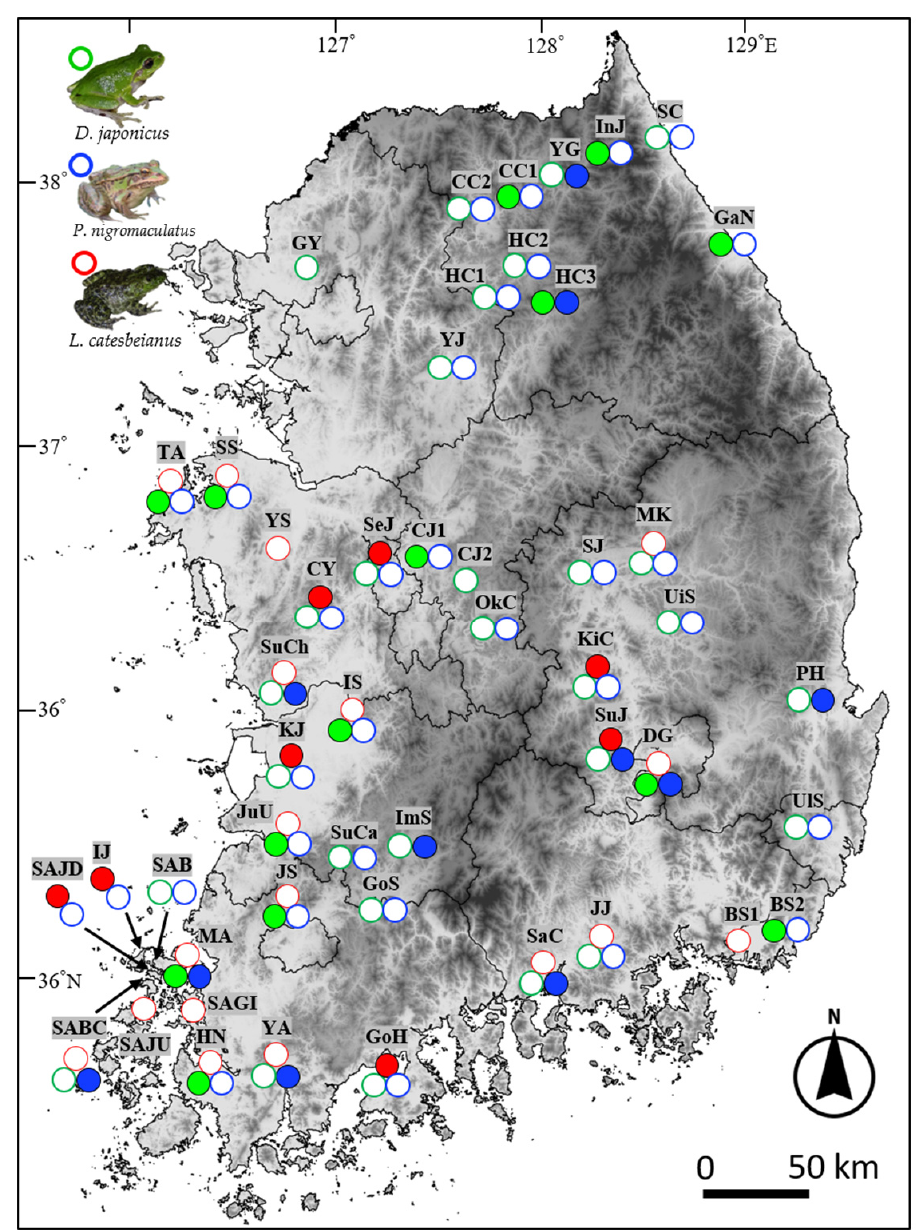
Figure 1. Local ranavirus infection in larvae of three anuran species ( Dryophytes japonicus , green circles; Pelophylax nigromaculatus , blue circles; Lithobates catesbeianus , red circles) at 49 locations across eight provinces in South Korea. Filled circles indicate the confirmation of at least one ranavirus-infected tadpole of the species at the location. Table 1. Sampling locations and ranavirus infection rates in larvae of three anuran species ( Dryo ‐ phytes japonicus , Pelophylax nigromaculatus , Lithobates catesbeianus ) across 49 sampling locations in South Korea.